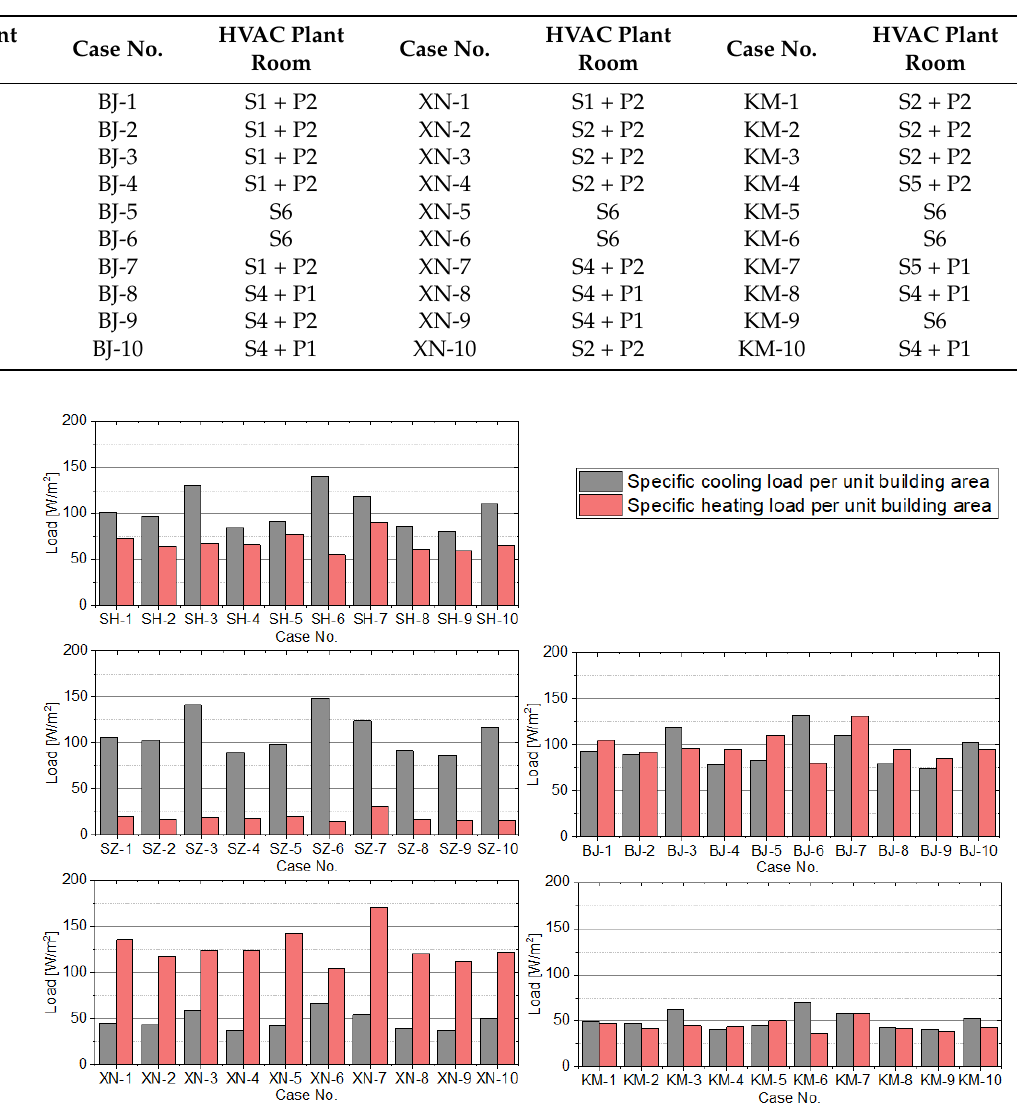
Table 7. Survey results of 40 generated artificial reference cases.